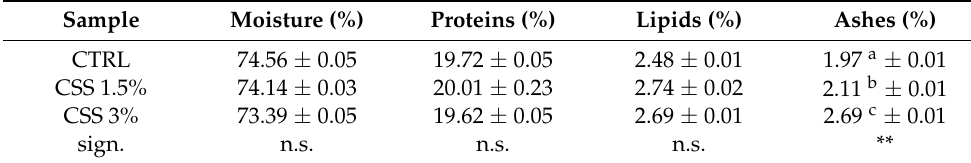
Table 1. Proximate composition (mean ± standard deviation, SD) of raw burger samples (before cooking): control (CTRL), with addition of +1.5% of coffee silver skin (CSS 1.5%) and +3.0% of coffee silver skin (CSS 3.0%). Sample